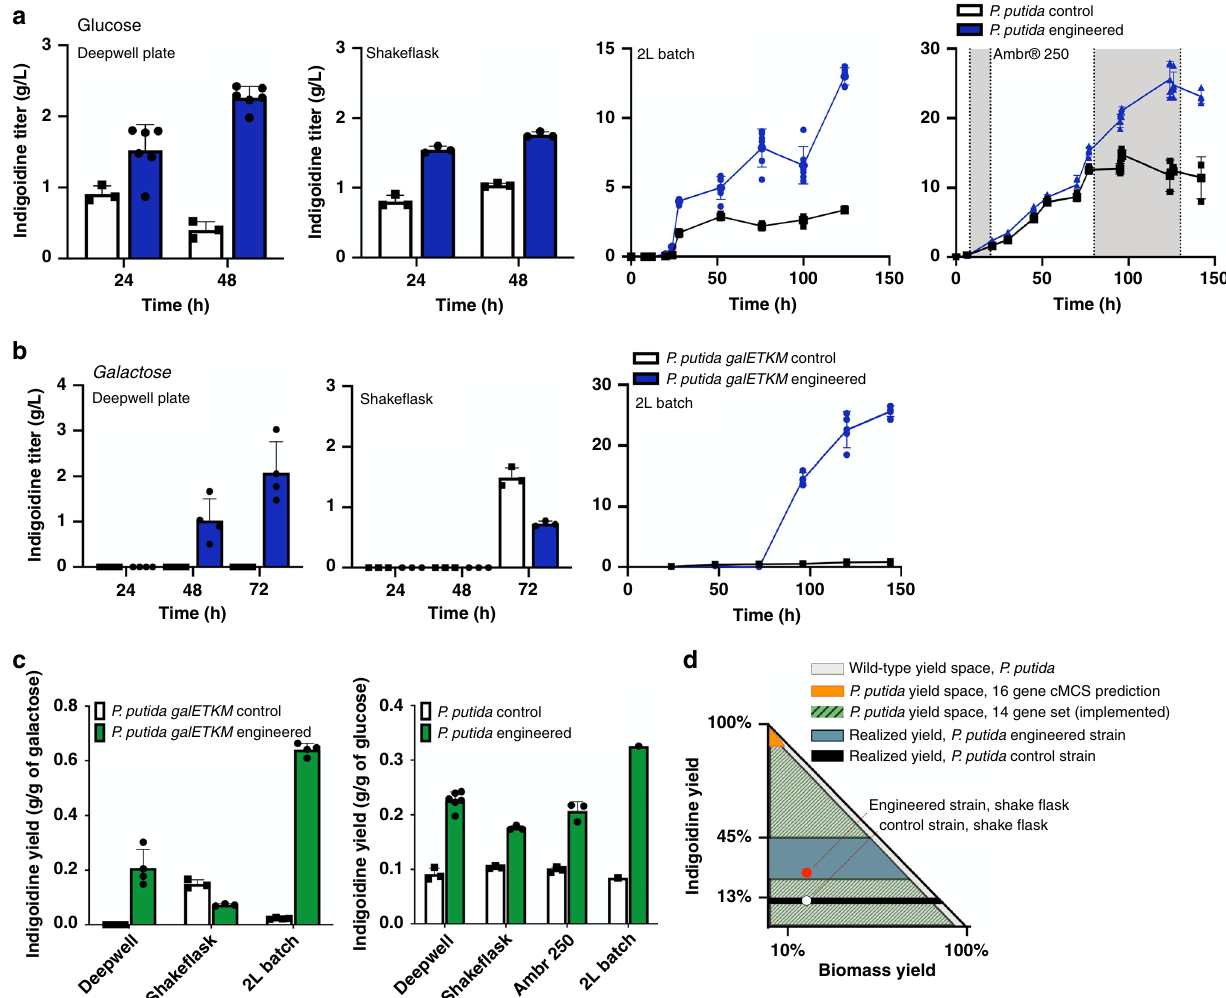
Fig. 3 The product substrate pairing approach can improve titer rate and yield across two carbon sources. a , b Analysis of P. putida galETKM multi-gene engineered strains and a control strain ( P. putida galETKM , empty vector plasmid) for production of indigoidine using glucose ( a ) or galactose ( b ) as the sole carbon source in M9 minimal medium. The culture format assessed is indicated above each panel. A fed-batch mode of cultivation was implemented in the ambr ® 250 cultivation format. Glucose feeding is indicated by the gray shaded area. Control samples indicated with black outlined bars or black dots. The multi-gene engineered strains are indicated with blue bars or blue dots. c Analysis of indigoidine yield across cultivation formats for both glucose-fed and galactose-fed strains. Yield from the control strain is indicated with black bars, and the multi-gene engineered strain is indicated with green bars. For the deep-well plate and shake fl ask experiments, data are presented as mean ± SD with an overlay of corresponding data points from n = 3 independent experiments. When the engineered strain was tested in the deep-well plate format and fed glucose, n = 6 independent experiments. For the industrially relevant formats (2 L and ambr250 ® ) data are presented as mean ± SD with an overlay of corresponding data points from biological duplicate and sampled each in technical triplicate. d Computed production envelope using genome scale model and constraint-based methods represented as theoretical yields of indigoidine as a function of biomass yields. Possible yield space for wild-type P. putida (gray fi ll), predicted 16-gene cMCS (yellow fi ll), down-selected and implemented 14 gene set (hashed green fi ll). The range of observed yield space for either the control (black fi ll) or engineered strain (teal fi ll) across different production formats is represented. The realized production yield vs. biomass yield in the shake fl ask format for engineered and control strain are represented by a red and white dot respectively. The phase shift in production from stationary phase to exponential is not depicted. Source data are provided as a Source Data fi